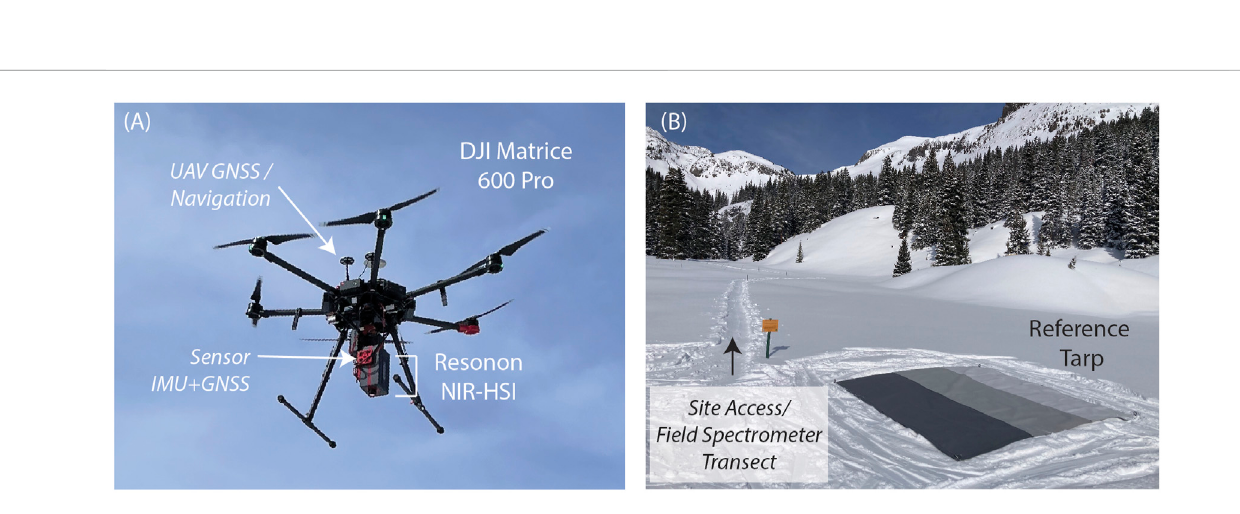
FIGURE 3 Photographs of (A) UAV-HSI system and (B) reference tarp at the fi eld location.